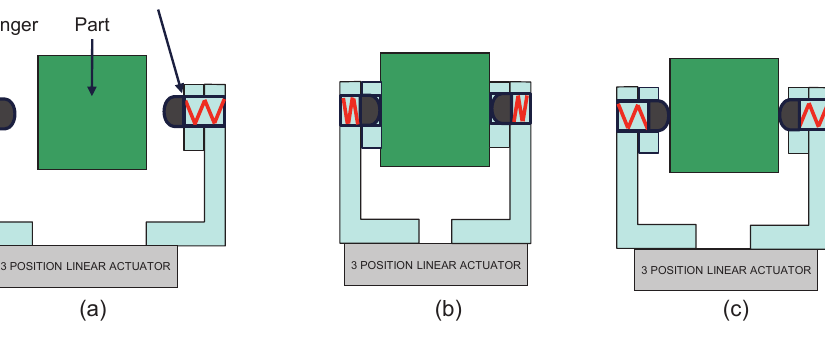
Figure 5. Parallel jaw gripper with spring actuated joints.